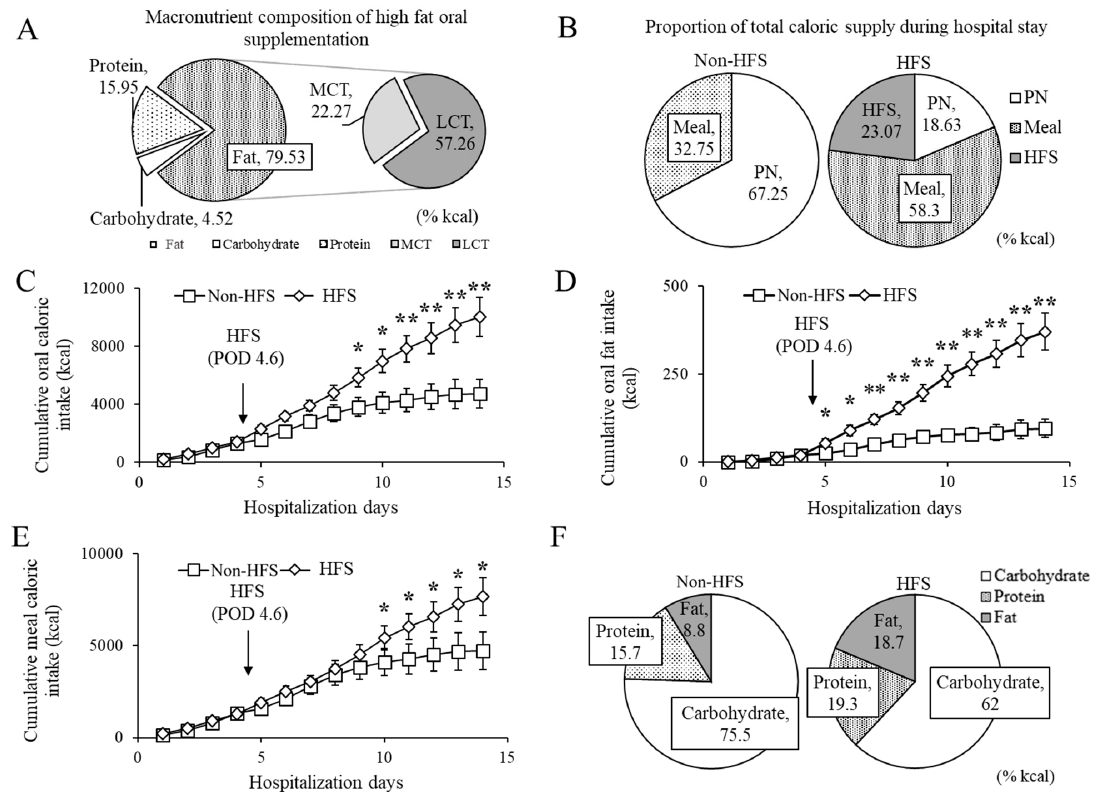
Figure 1. Nutritional composition of high fat oral supplement (HFS) and cumulative intake calories in postoperative pancreatic cancer patients. ( A ) Macronutrient composition of high fat oral supplementation (%kcal); ( B ) proportion of total caloric supply during hospital stay; ( C–F ) cumulative oral caloric intake, cumulative oral fat intake (kcal), cumulative meal caloric intake, and proportion of oral macronutrient composition by postoperative days during the entire hospitalization period.